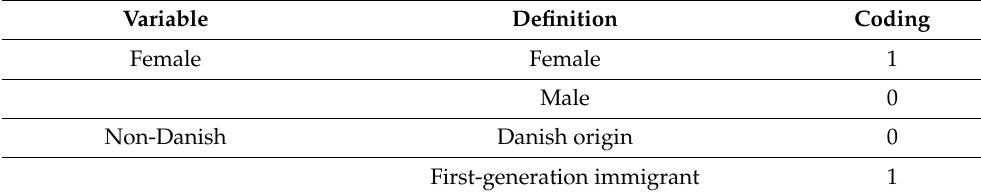
Table A1. Binary coding of included background